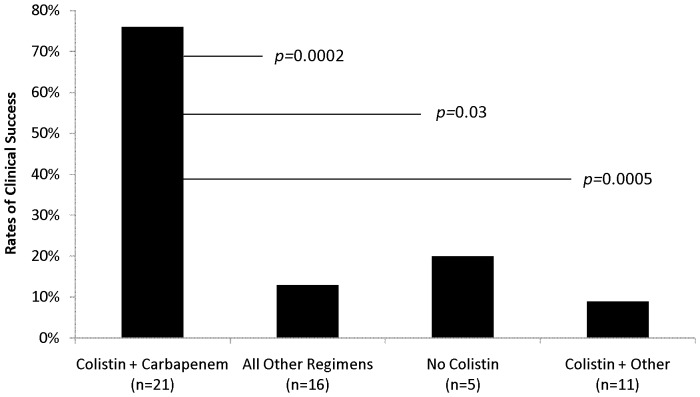
This figure provides a graphical representation of 28-day clinical success rates and compares colistin-carbapenem regimens to other treatment regimens.